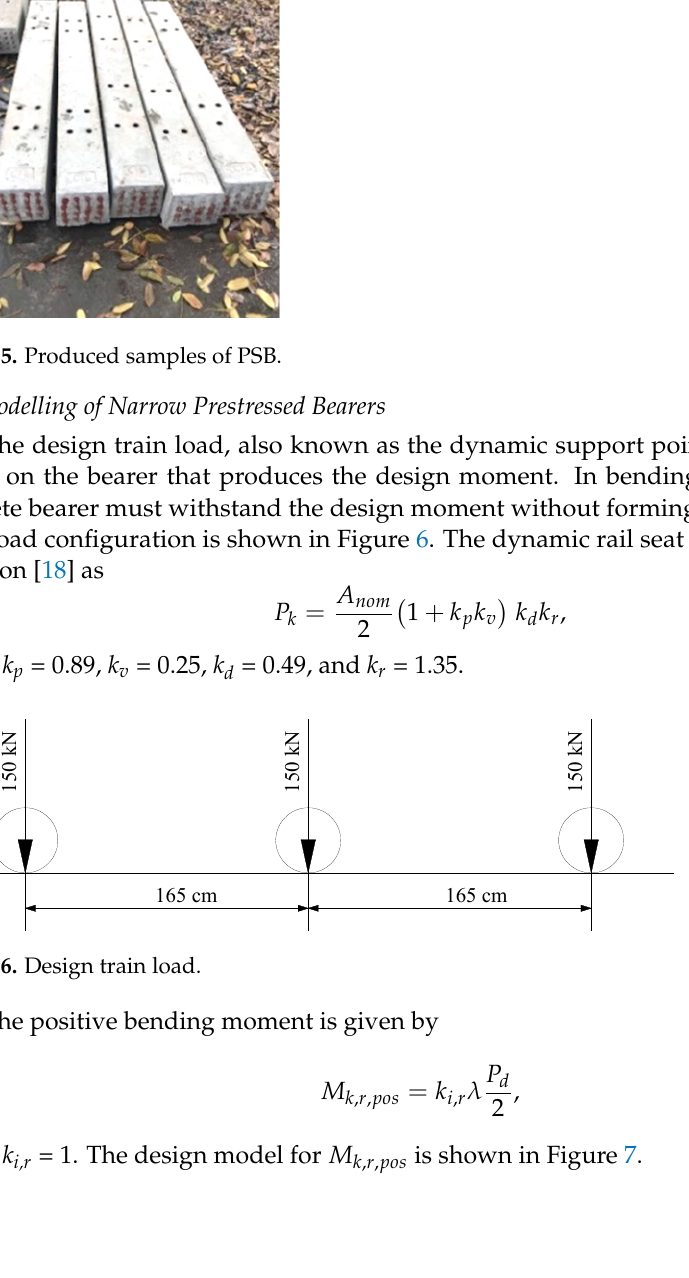
Figure 4. Manufacturing of the PSB samples in the factory. ( a ) Preparing the molds; ( b ) Pre-tension- ing of the strands; ( c ) Concreting into the molds.